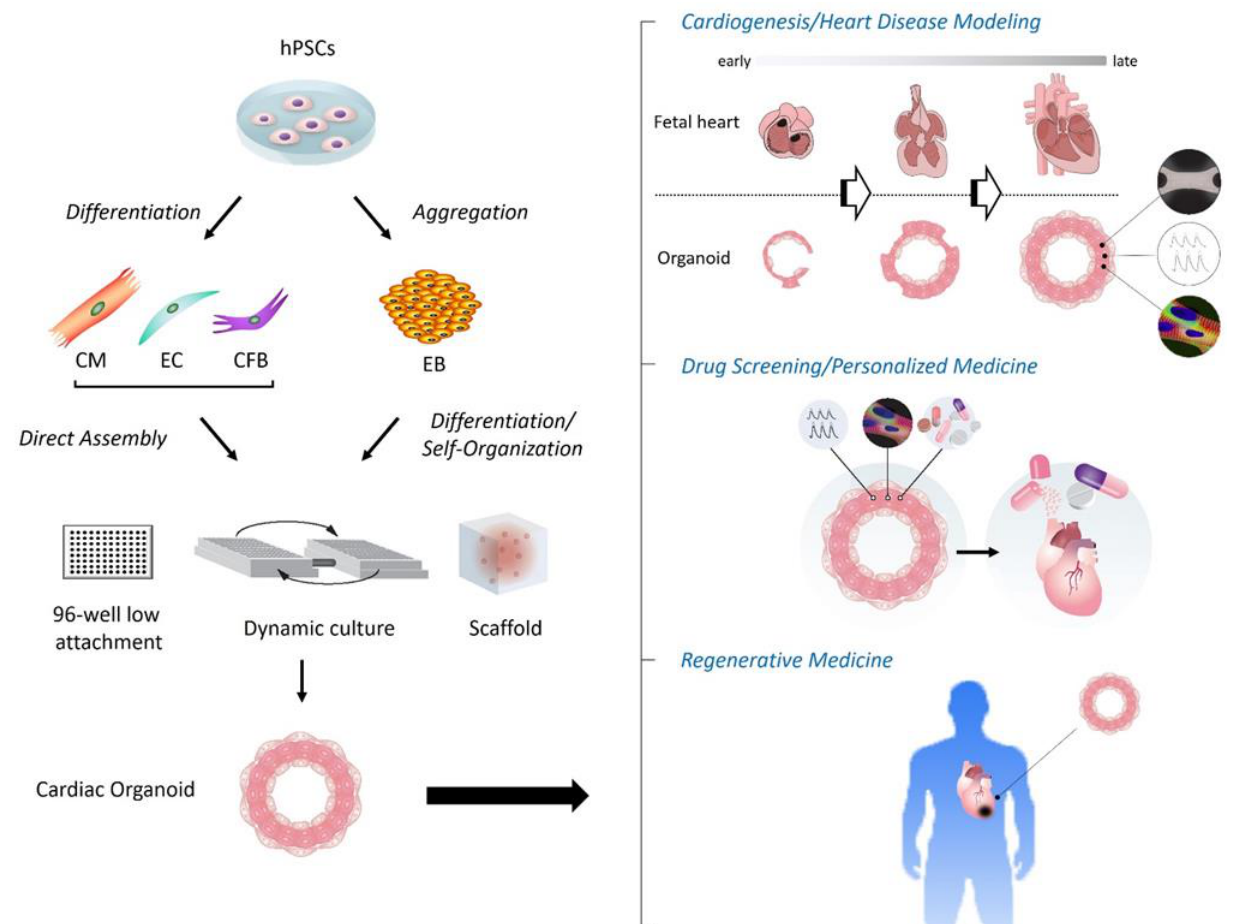
Figure 1. Schema of construction and applications of human cardiac organoids. ( Left ) Following aggregation or directed differentiation of hPSCs, cardiac organoids are constructed by differentia- tion and self-organization of aggregated hPSCs (i.e., EBs), or direct assembly of hPSC-derived car- diac cells such as CMs, ECs and CFBs under the 3D environment with anti-adherent culture plates, dynamic culture (shaking), and/or biological scaffolds. ( Right ) The applications of cardiac organ- oids involve the modeling of cardiogenesis and/or heart diseases, drug screening and development with or without targeting personalized medicine, and regenerative medicine. CFB, cardiac fibro- blast; CM, cardiomyocyte; EB, embryoid body; EC, endothelial cell; hPSC, human pluripotent stem